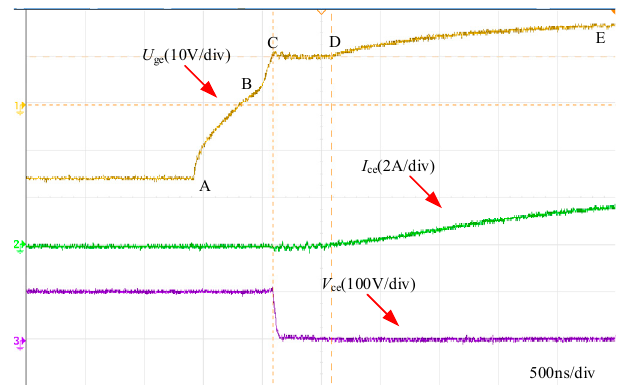
Figure 5. Comparison chart of U ge , I ce , and V ce .